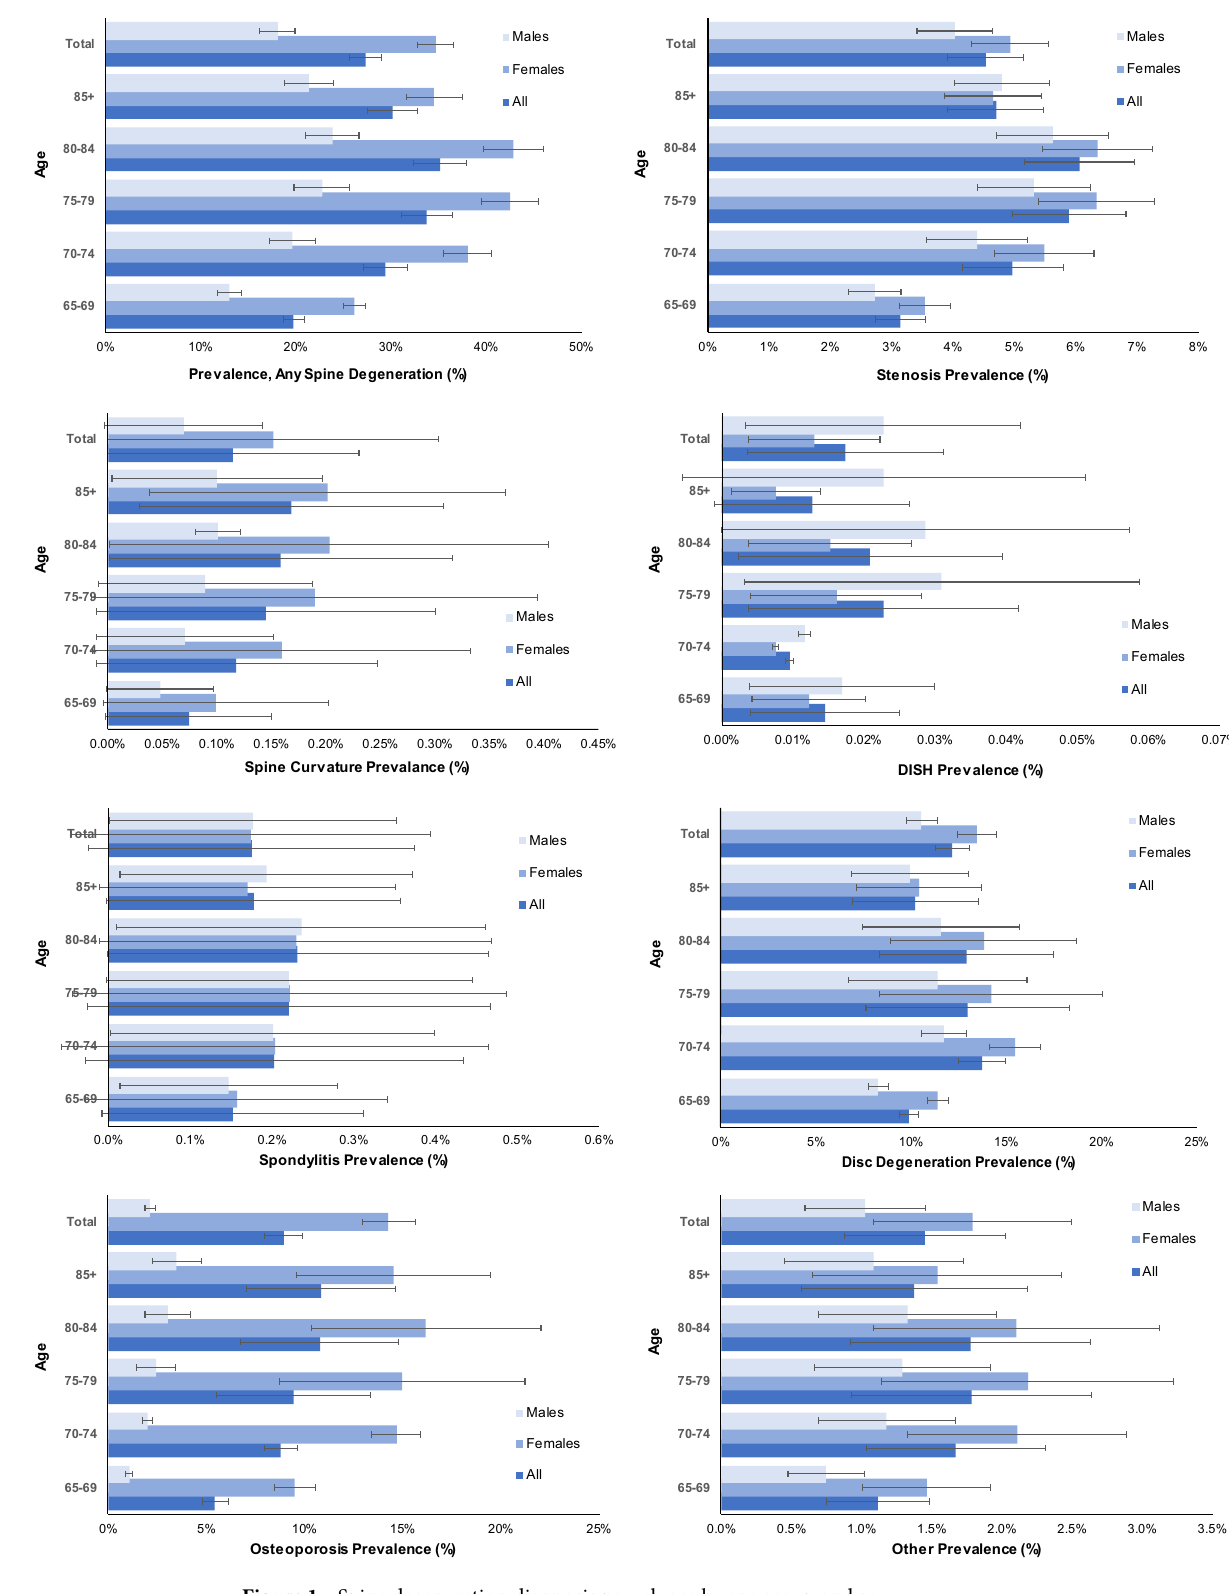
Figure 1. Spine degeneration diagnosis prevalence by age group and